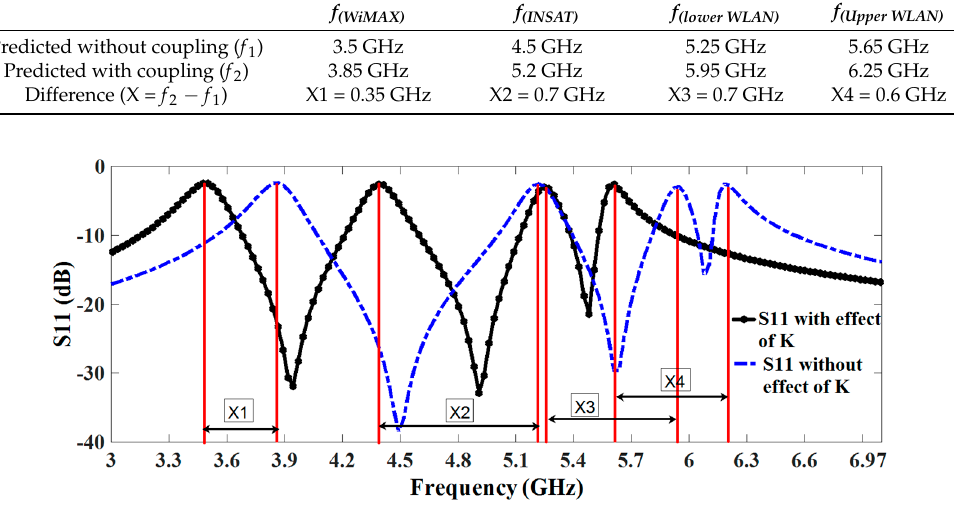
Figure 4. Corresponding shift in the frequency response of each rejection band caused by coupling effect.